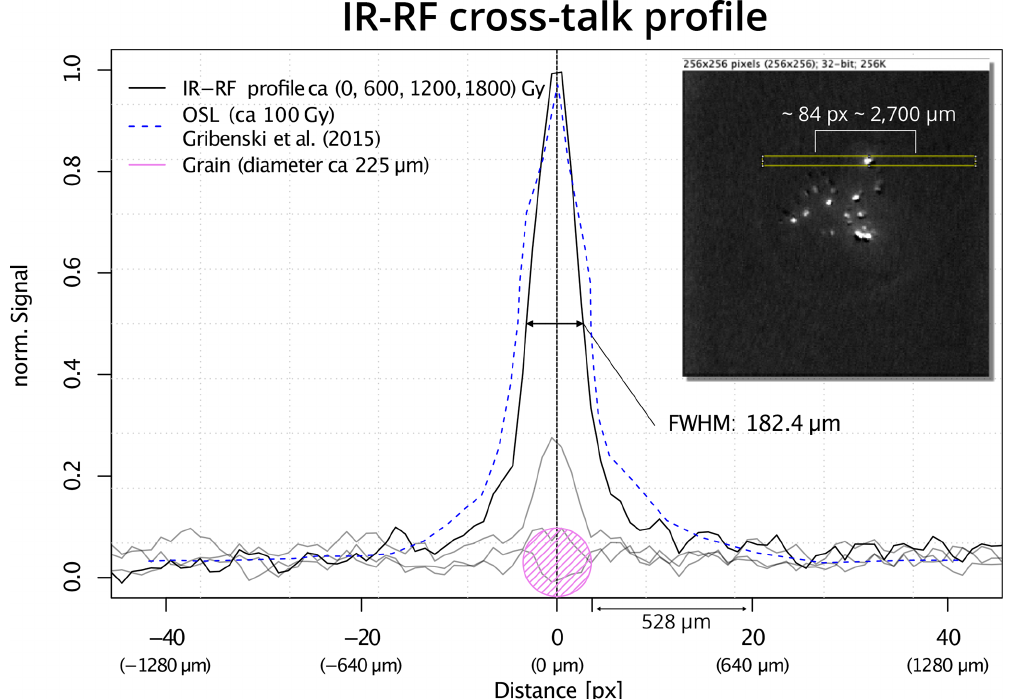
Figure 4. IR-RF cross-talk profile of one single grain. The inset shows the ImageJ image with the rectangle area selected for the profiling over ca. 1800Gy (along the all image slices of the image stack). The solid black lines show the IR-RF signal. For illustrative reasons, we show only a few curves. The dashed blue line shows the approximated OSL cross-talk profile recorded by Gribenski et al. (2015) after a dose of ca. 100Gy. The violet shaded area approximates the grain (not in height but width). Please note that the data by Gribenski et al. (2015) were only added to provide a rough qualitative comparison. Please note that the metric distances (sub-labels) refer to the chip